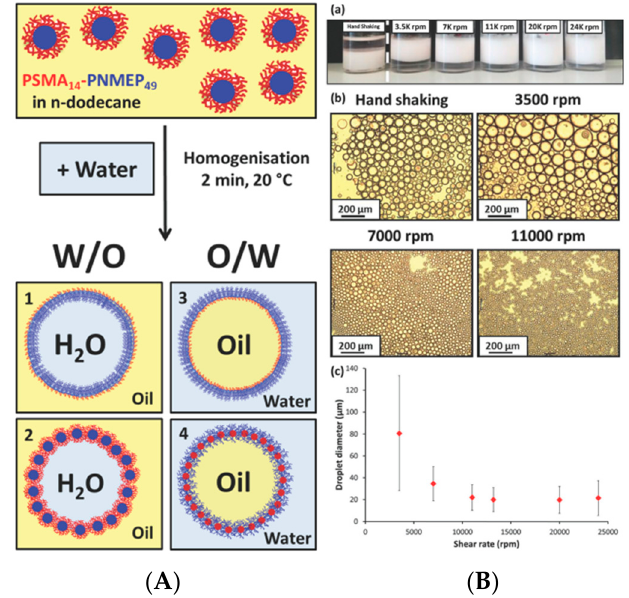
Figure 12. ( A ) Schematic representation of the four possible types of emulsions which could form as